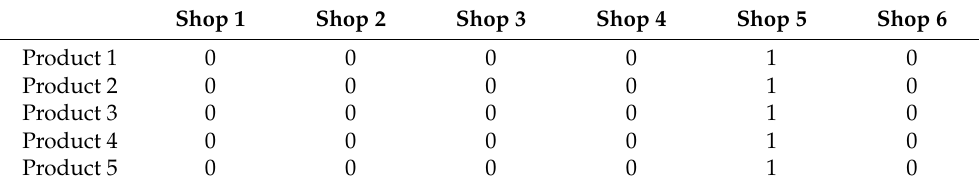
Table 9. Numerical solution results of the initial master (products). Shop 1 Shop 2 Shop 3 Shop 4